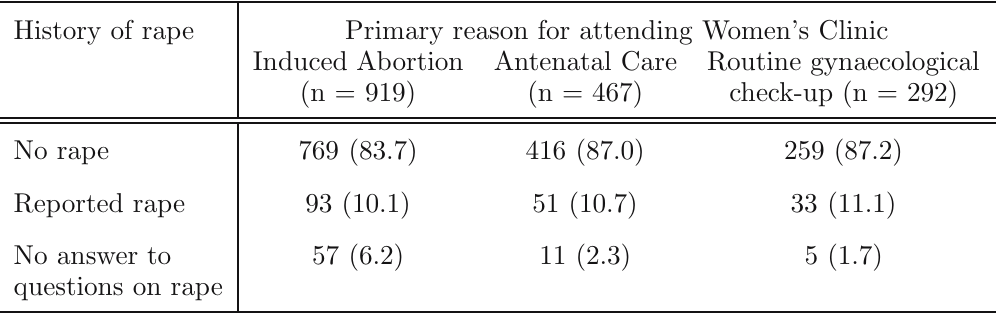
Table 1 History of rape in the study population, n